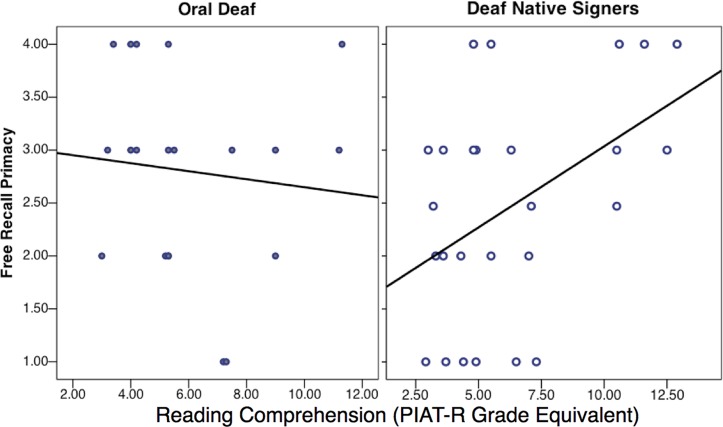
Regression Plots of the Effect of Free Recall Primacy on Reading Comprehension in Deaf Groups.